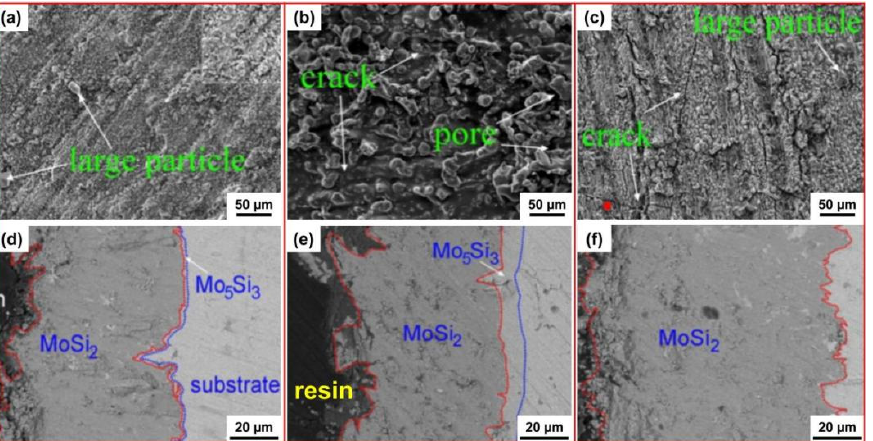
Figure 3. Surface and cross-sectional back scatter electronic (BSE) images of MoSi 2 coatings prepared with Al 2 O 3 ( a , d ), SiO 2 ( b , e ), and SiC ( c , f ) filler in the pack, respectively. Reprinted with permission from [30]; Reproduced from (Sun et al., 2016).